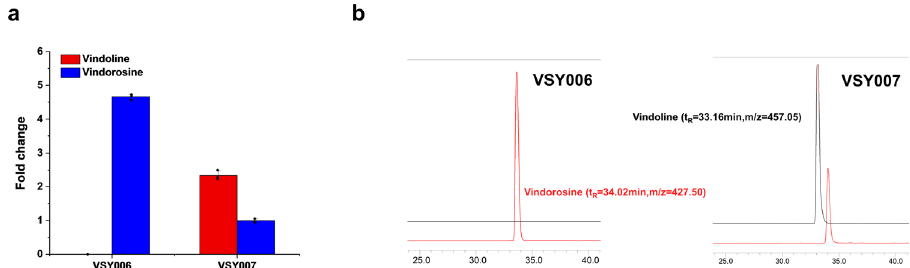
Fig. 2 Comparison of vindoline and vindorosine production in engineered S. cerevisiae strains. a Productivity changes of vindoline and vindorosine in strain VSY006 and VSY007, with the production level of vindorosine in strain VSY006 set as the reference value. b MS spectra of vindoline and vindorosine produced by strain VSY006 and VSY007, respectively. Error bars represented SD of biological triplicates ( n = 3).